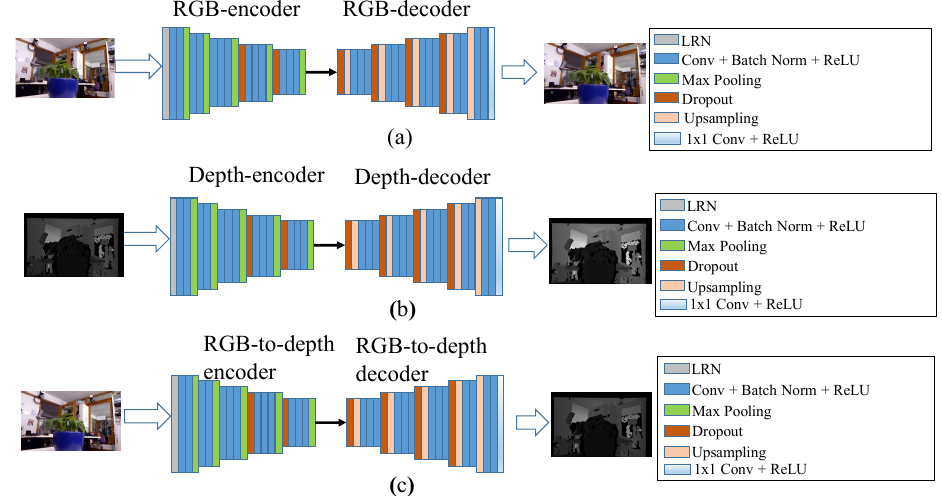
Figure 4. In deep feature learning neural networks (DFLNN) which consists of an encoder, a decoder, and a 1 × 1 convolutional layer: ( a , b ) are the neural networks that transform the original RGB and depth images into the quantized versions, respectively; ( c ) is the depth recovering neural network (DRNN).